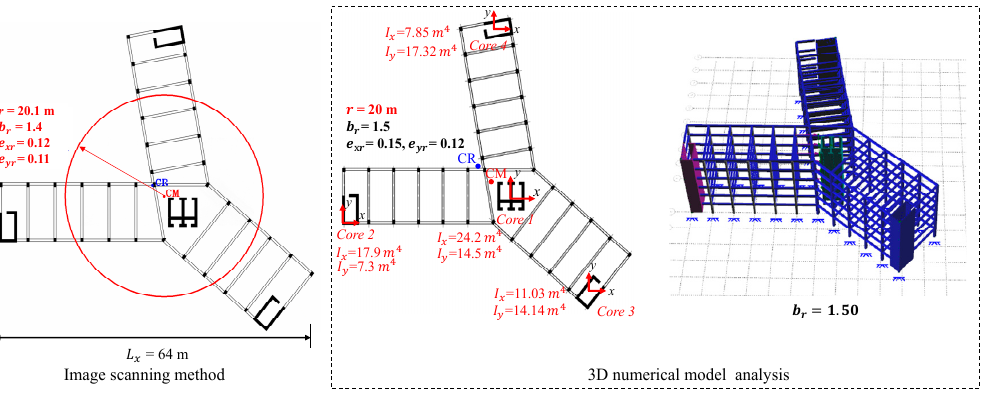
Figure A1. Comparisons of results obtained from the image scanning method and the 3D numerical model.